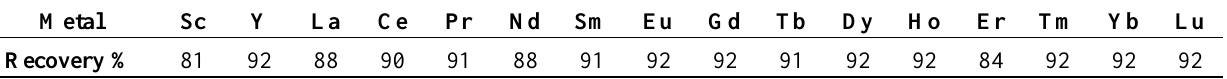
Table 1. Stripping percentages of rare earth elements from the Zonyl FSA ®